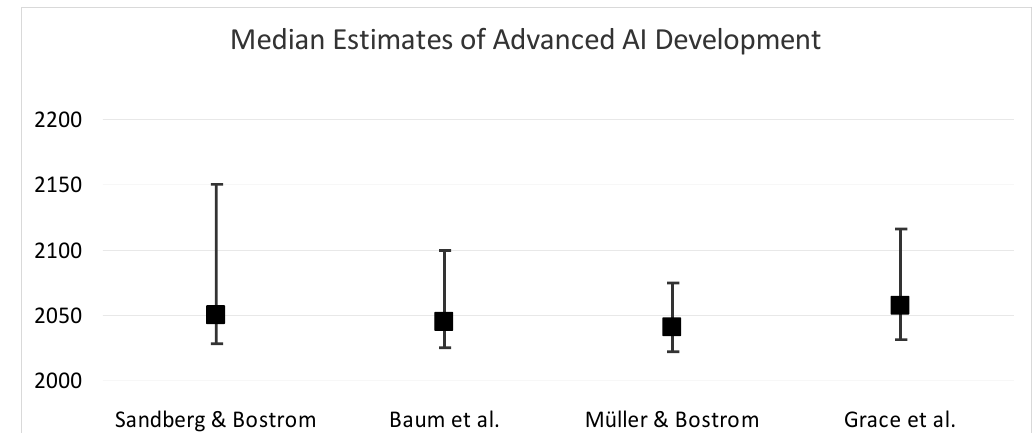
Figure 1. Estimates for when AI will reach superhuman capability (Baum et al.) [23] and human-level capability (Sandberg and Bostrom, Müller and Bostrom, and Grace et al.) [24–26]. Shown are estimates for when the probability that the milestone is reached is 10% (lower mark), 50% (square), and 90% (upper mark). For each study, the median estimates across the survey participants are